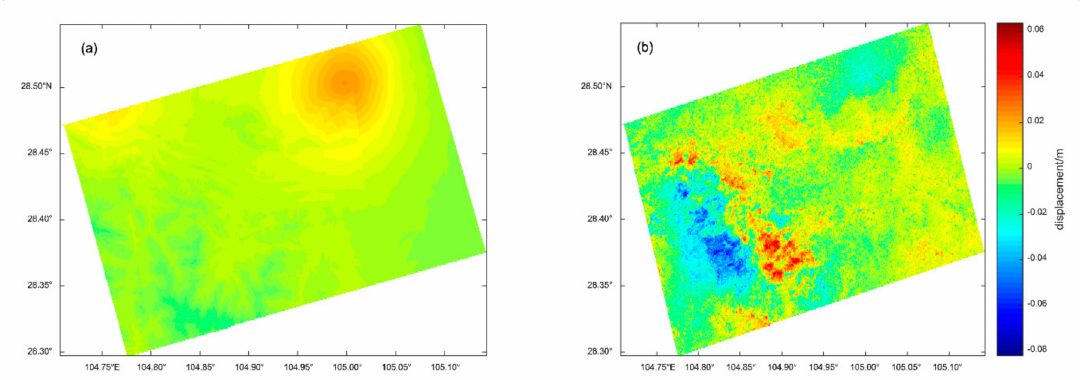
Figure 6. The corrected deformation displacement according to the atmospheric delay model based on the VCE method: ( a ) the multi − source data integrated atmospheric delay correction model based on the variance component estimation (VCE) method; ( b ) the corrected co − seismic deformation displacement according to the model based on the VCE. The color − coded strip represents the atmospheric delay correction model and the displacement in ( a , b ),